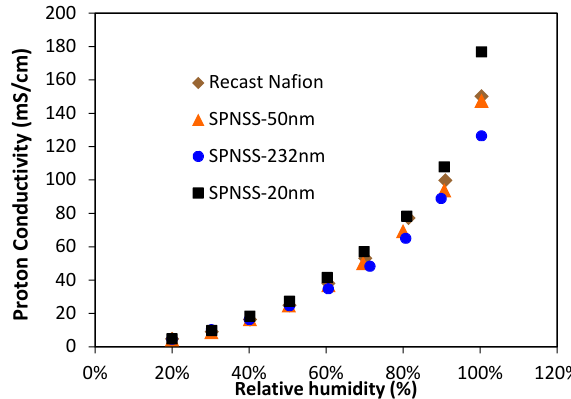
Figure 2. Proton conductivity of SPNSS nanocomposite membranes with recast Nafion at 80 °C. Proton conductivity increases with increase in relative humidity (RH) for all samples.